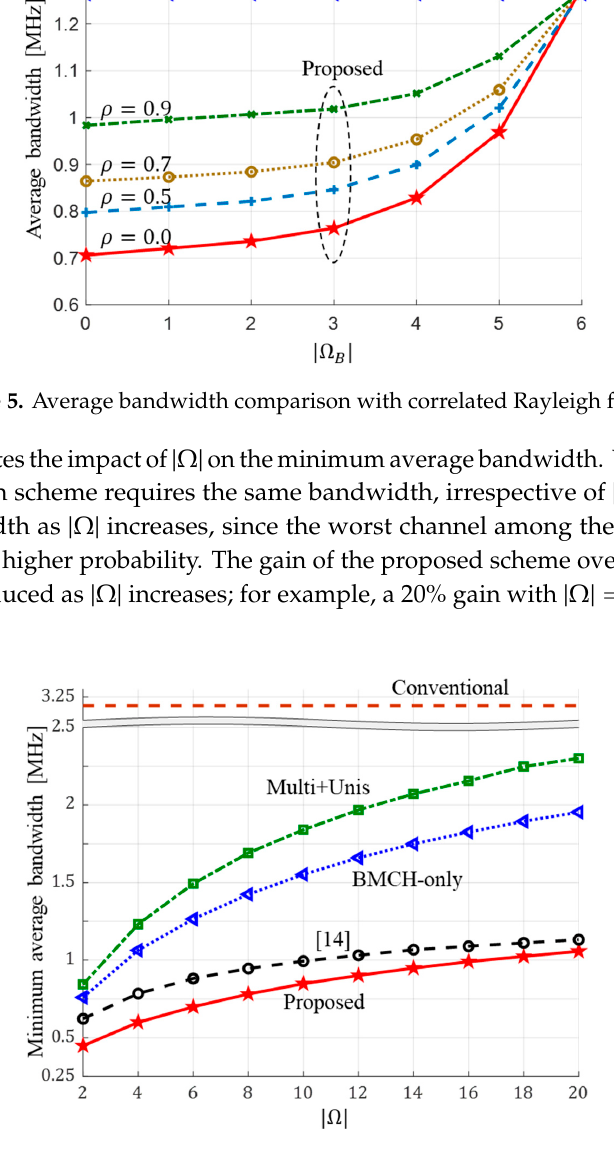
Figure 6. Minimum average bandwidth versus |𝛺|